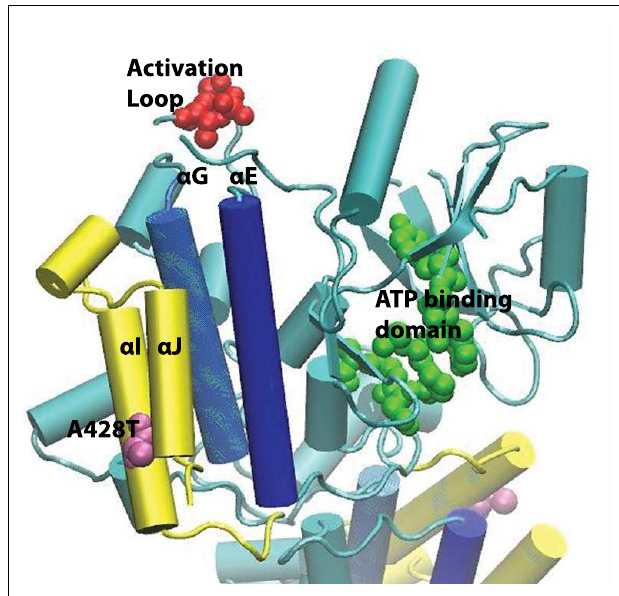
FIGURE 2 | Structural features of the IRAK4 kinase domain .The Ala428Thr (mauve) non-synonymous SNP is located on α I, the penultimate alpha helix, facing the carboxy terminal α J as part of the putative extreme carboxy terminal (XCT) subdomain (yellow). Preliminary molecular dynamics simulations superpositioned backbone atoms of α I (yellow), α G (blue), and α E (blue) to evaluate local structural changes introduced by replacing Ala428 withThr.The location of key residues in known functional domains, includingThr342,Thr345, and S346 of the activation loop (red) and amino acids 262 through 269 in the ATP binding domain (green) are also indicated.